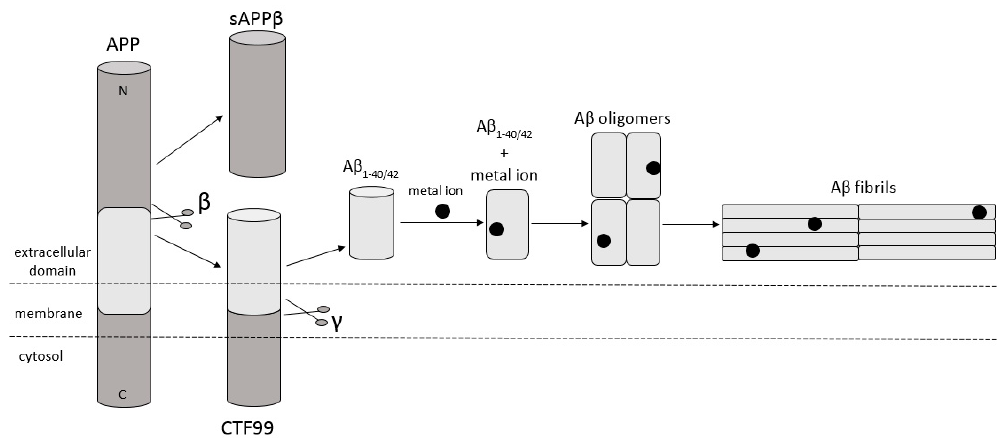
Figure 2. Schematic diagram illustrating cleavage of APP in the amyloidogenic pathway, when APP is cleaved by β - and γ -secretase, respectively, and forms full-length A β 1–40 / 42 peptides. This peptide can interact with metal ions from the brain, forming A β oligomers and then A β fibrils. Based on